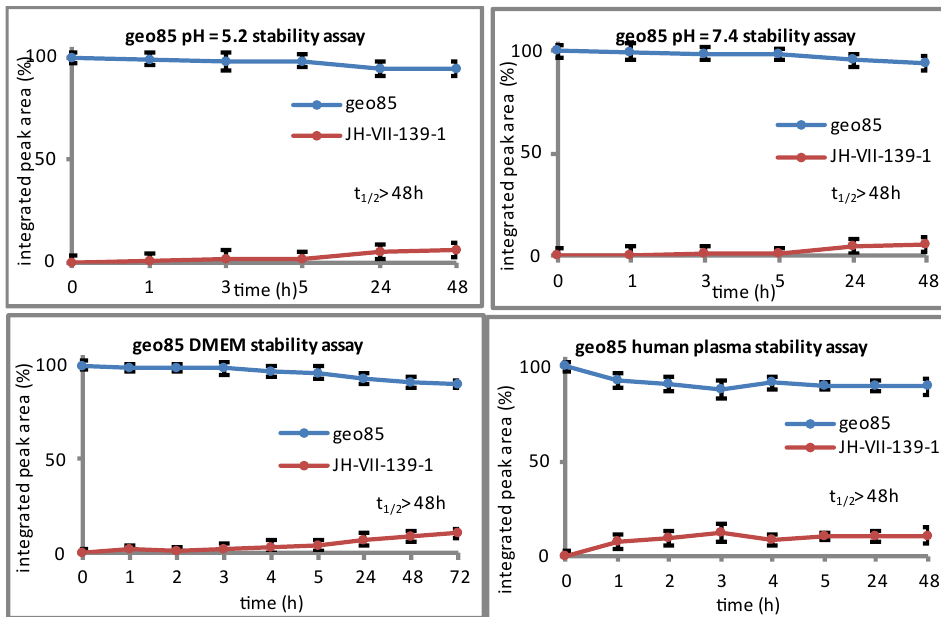
Figure 5. Chemostability of conjugate geo85 .